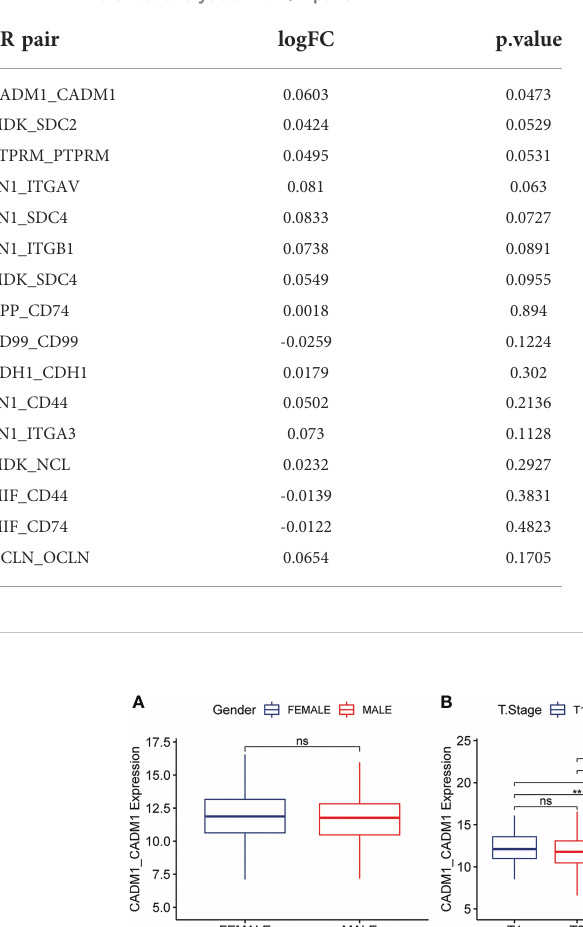
TABLE 2 Differential analysis of 16 L/R